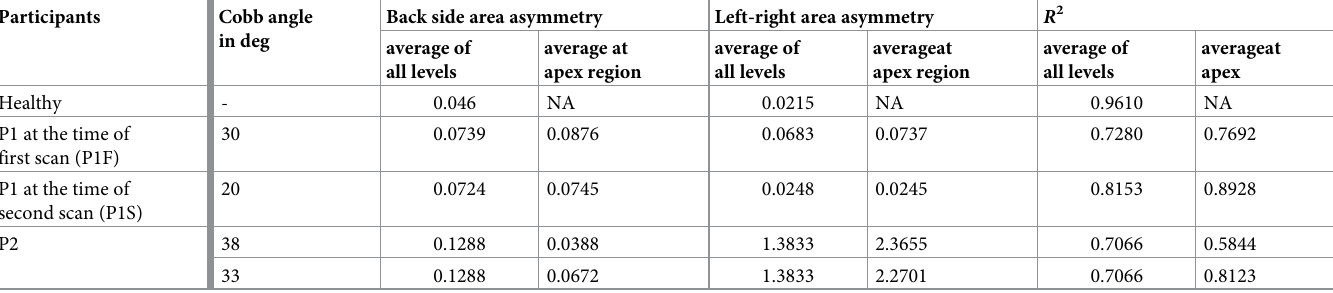
Table 2. Mean of the evaluated asymmetry parameters for all the levels and at the apex. Participants Cobb angle Back side area asymmetry Left-right area asymmetry R 2 in deg average of average at average of averageat average of averageat all levels apex region all levels apex region all levels apex Healthy 0.046